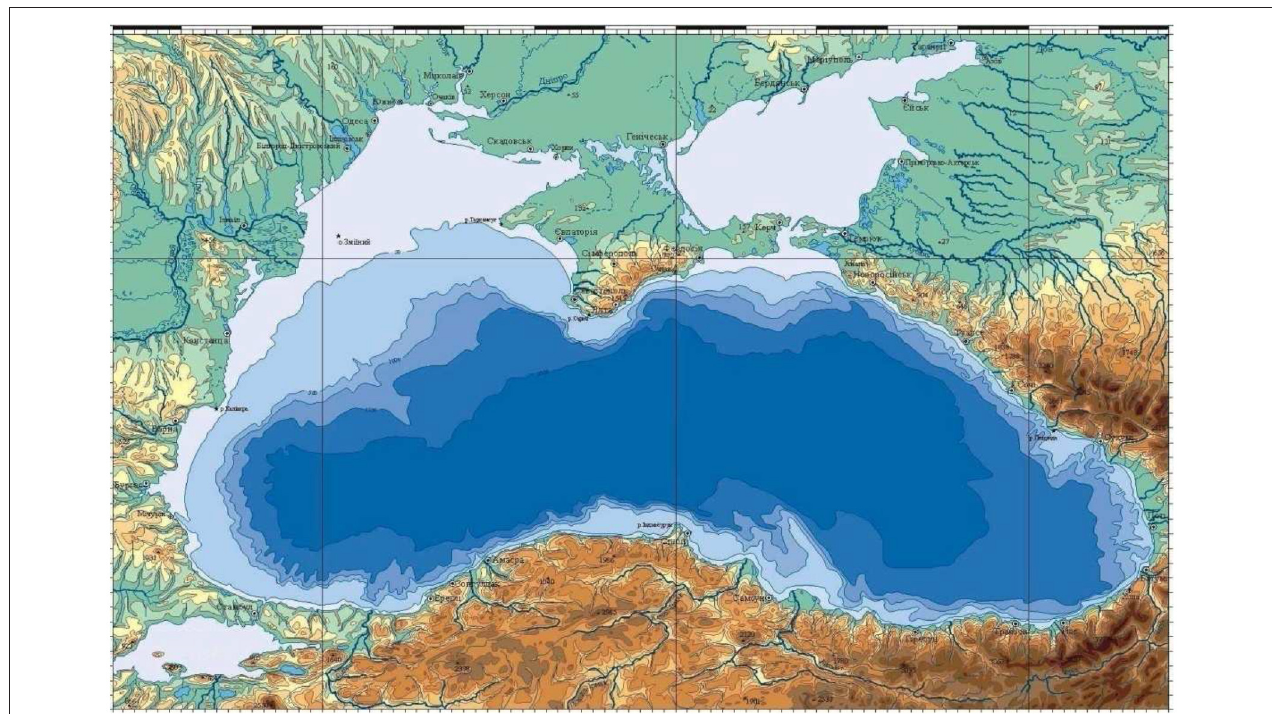
FIGURE 1 | The location and bathymetry of the Black Sea.